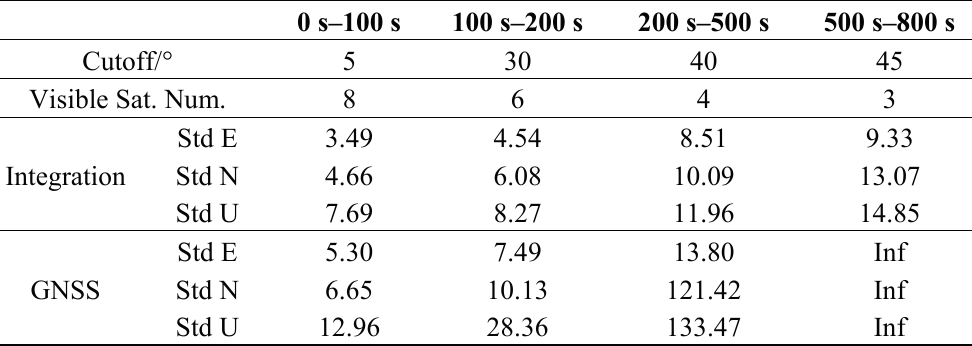
Figure 20. DOPs of integration and GNSS. Table 5. Comparison of Integration and